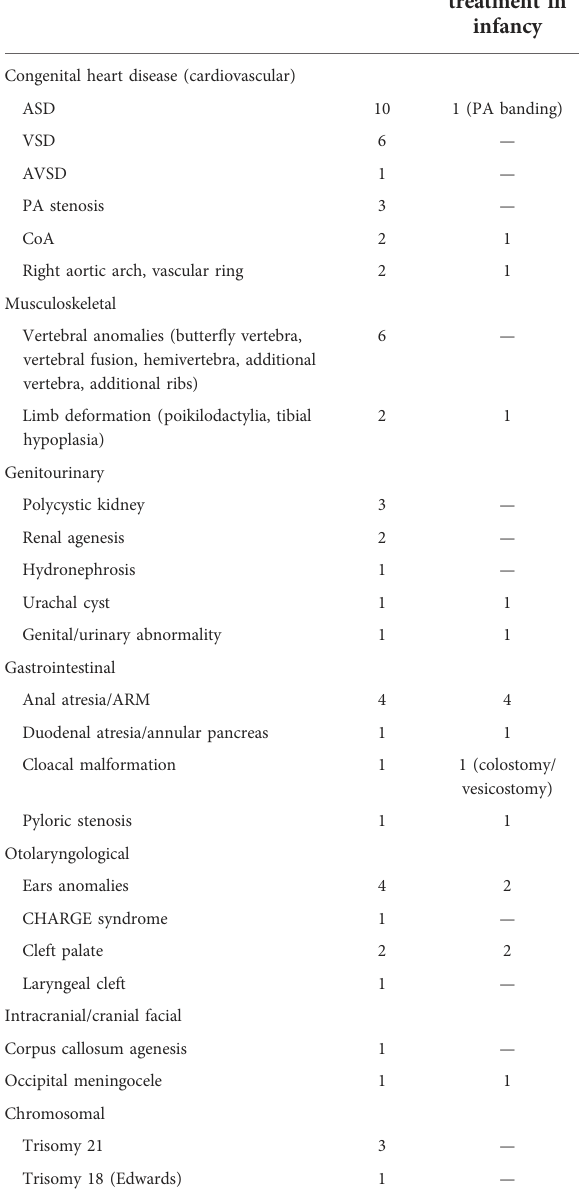
TABLE 3 Coexisting congenital defects. Characteristics